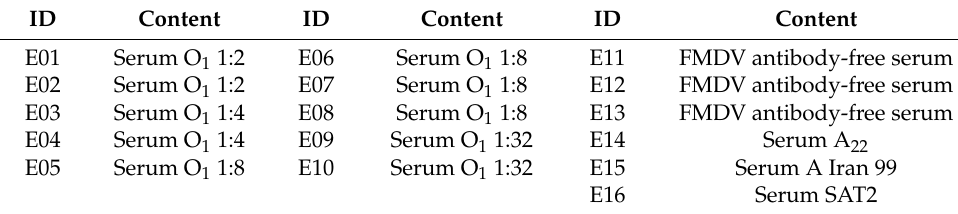
Table 2. Sample panel for serological